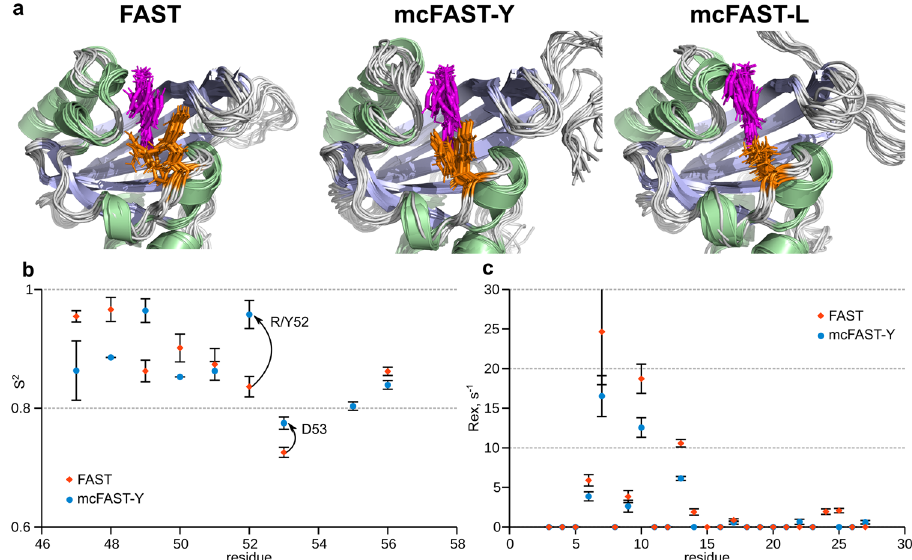
Fig. 5 Dynamics of FAST brightest mutants. a 11 structures of FAST/ N871b complex (FAST, mcFAST-Y and mcFAST-L mutants), selected from the last 10 ns of the MD simulation in 1 ns interval. N871b is shown in magenta and the sidechain of residue 52 is shown by orange sticks. Structures are superimposed over the backbone atoms of the β -sheet residues. b Generalized order parameters S 2 are shown for residues 47-56 of FAST (blue circles) and mcFAST-Y (orange rhombuses), according to the model-free analysis of 15 N relaxation parameters. Changes, observed for residues 52 and 53 are shown by arrows. c Contributions of slow µ s-ms motions to the transverse relaxation of the N-terminal residues (3-27) of FAST (blue circles) and mcFAST- Y (orange rhombuses). Error bars in panels b and c correspond to the errors of parameters of approxiamtion, determined by the Monte-Carlo